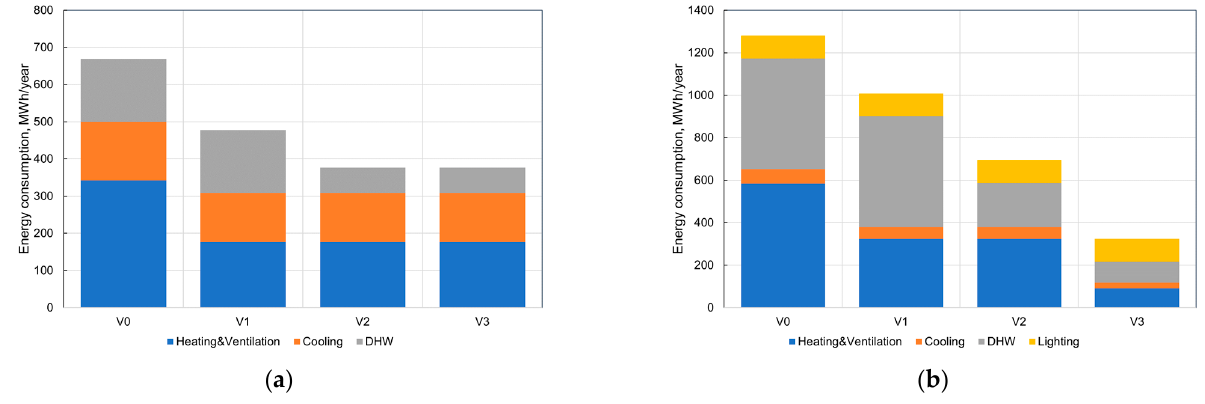
Figure 7. Energy demand structure for all variants: ( a ) usable energy; ( b ) final energy.